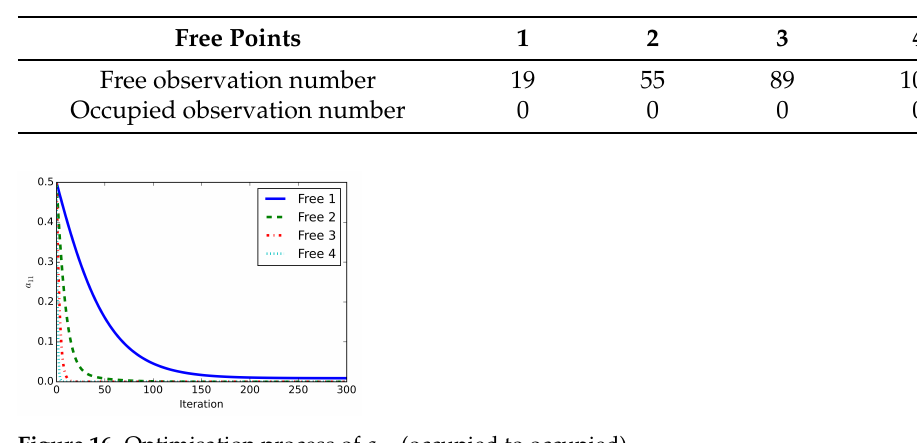
Figure 16. Optimisation process of a 11 (occupied to occupied).